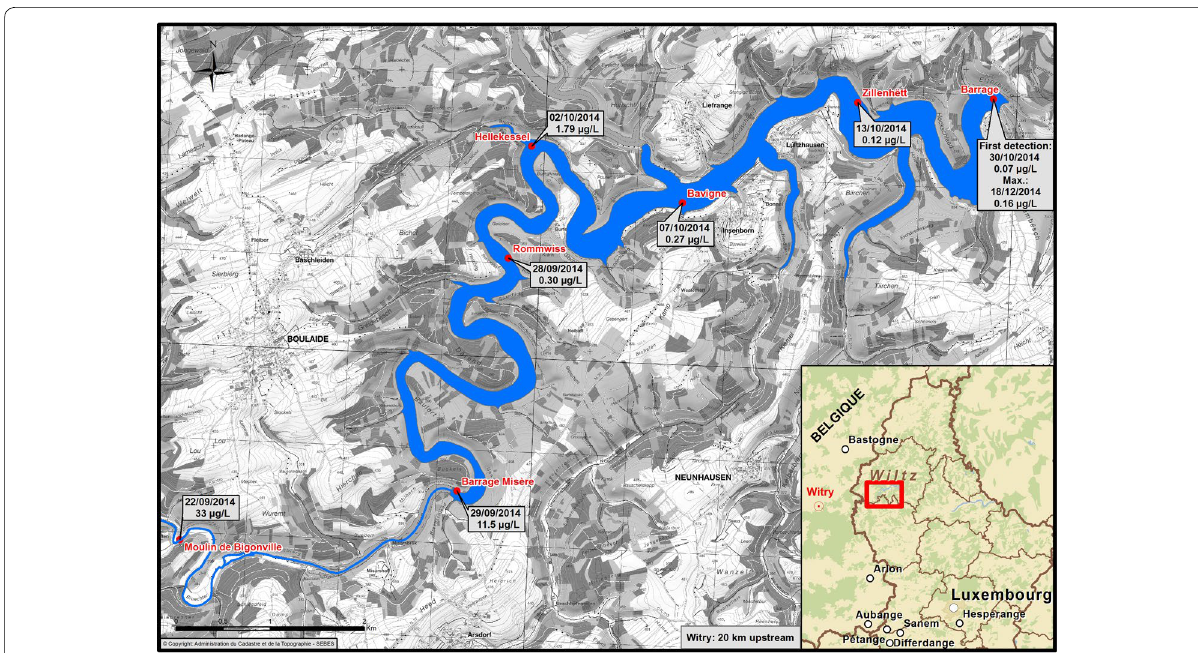
Fig. 2 Situation of the lake of the Upper-Sûre and the measure points. Unless differently stated, the indicated values are the highest detected concentrations of